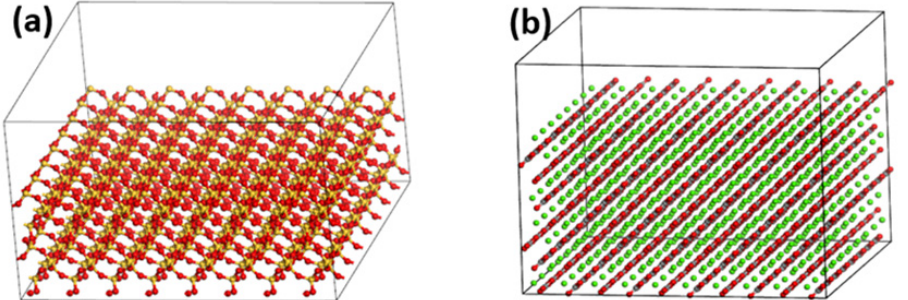
Figure 7. ( a ) The supercell model of SiO 2 ; ( b ) The supercell model of CaCO 3 .